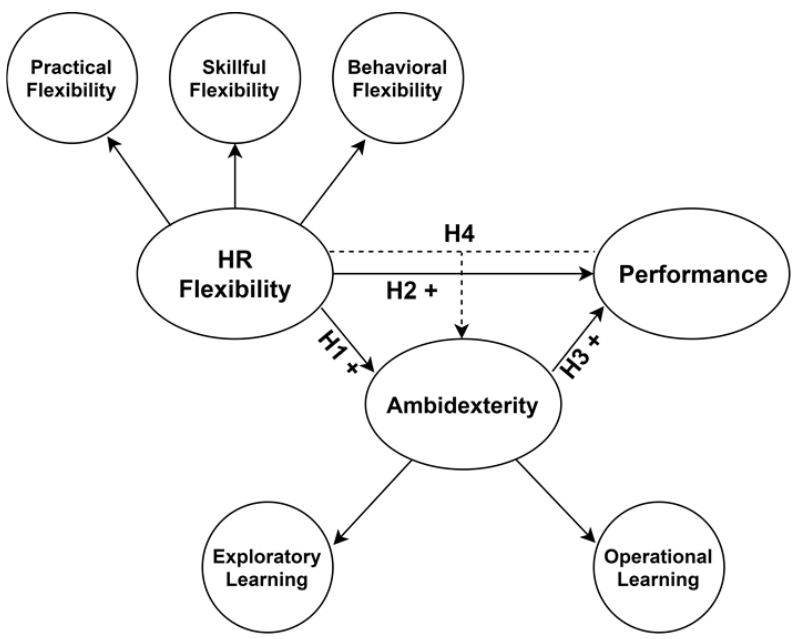
Figure 1. Conceptual model of the research as proposed by